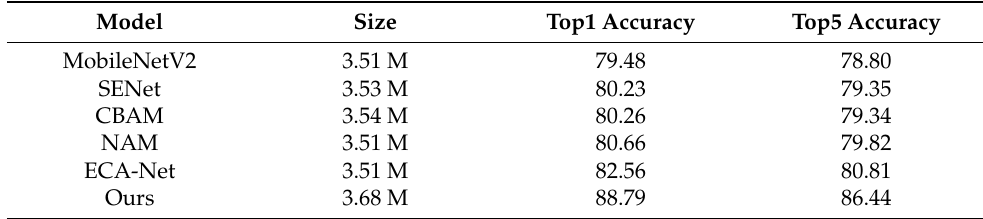
Table 3. Results of comparative experiment of